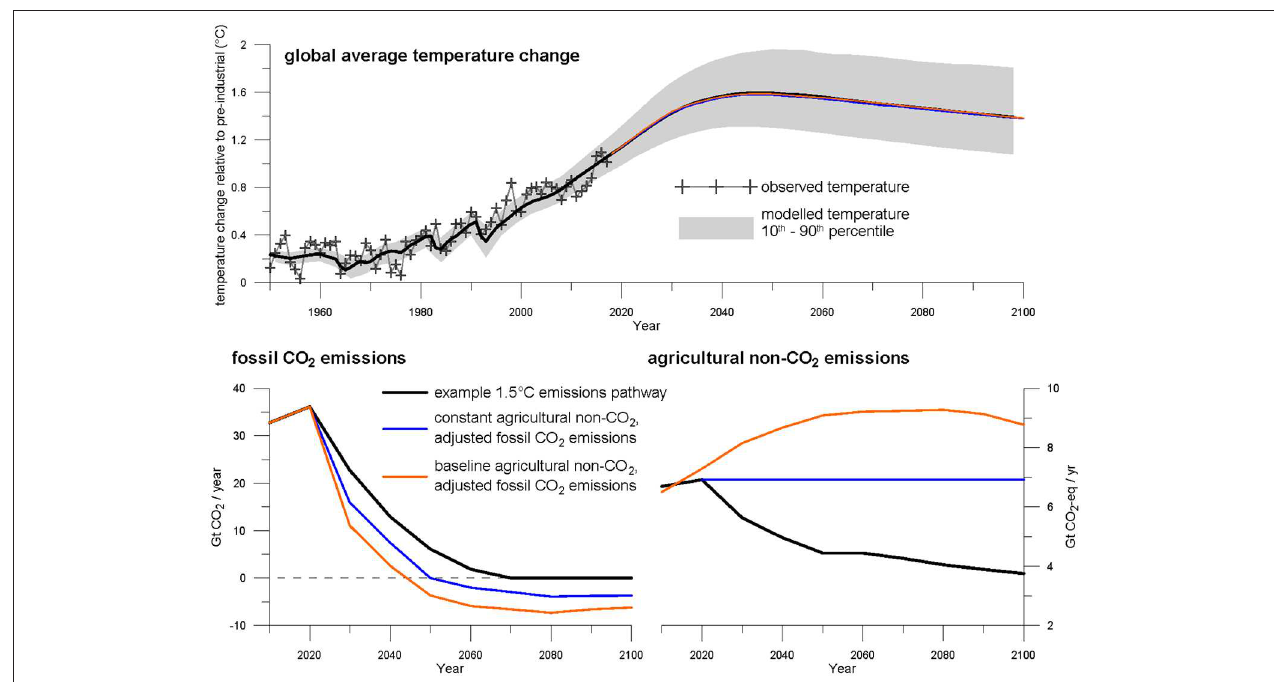
FIGURE 1 | Three alternative global pathways of fossil CO 2 and agricultural non-CO 2 (CH 4 and N 2 O) emissions consistent with global warming of 1.5 ◦ C. The lower panels show fossil CO 2 (left panel) and agricultural non-CO 2 (right panel) emissions. The black line shows an illustrative global emissions pathway that would limit warming to 1.5 ◦ C with limited (0.1 ◦ C) overshoot. The red line shows an emissions pathway where agricultural non-CO 2 emissions are not mitigated, i.e., follow a baseline projection, and fossil CO 2 emissions are adjusted downwards to result in the same global average temperature change from all gases throughout the twenty-first century, including through negative emissions from about 2045 onwards. The blue line shows an intermediate pathway where agricultural non-CO 2 emissions are held constant from 2020 onwards and fossil CO 2 emissions are again adjusted to produce the same overall global average temperature change. Emissions and removals of all other gases, and for CH 4 and N 2 O from other sectors, follow the same unchanged illustrative 1.5 ◦ C mitigation pathway in all three scenarios. The top panel shows observed (HadCRUT4: Morice et al., 2012) and modeled global average temperatures for all three pathways (probabilistic median and 10–90 percentile range, using MAGICC; Meinshausen et al., 2009,